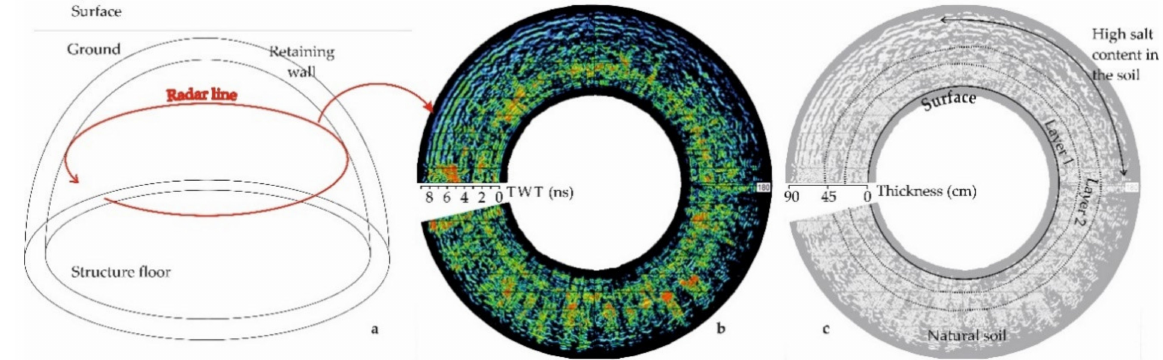
Figure 7. GPR images from the study of the retaining walls in a subterranean tomb (adapted from Santos-Assunçao et al. [121]). ( a ) Scheme of the structure and location of the profile line (in red). ( b ) Processed GPR image. ( c ) Data interpretation. The wall is composed of two layers of uneven stones. The contact with the natural soil is detected and the changes in the amplitude denote changes in the soil salt content, which could affect the preservation of the